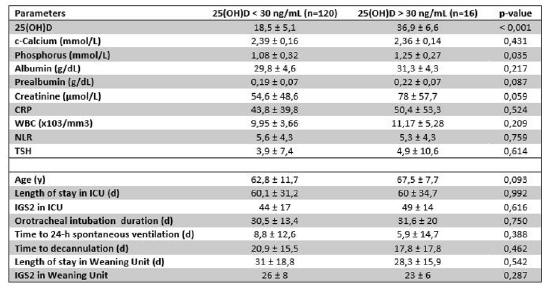
FC‑202 Impact of time of administration and dose of desmopressin in brain‑dead donors: a before‑after